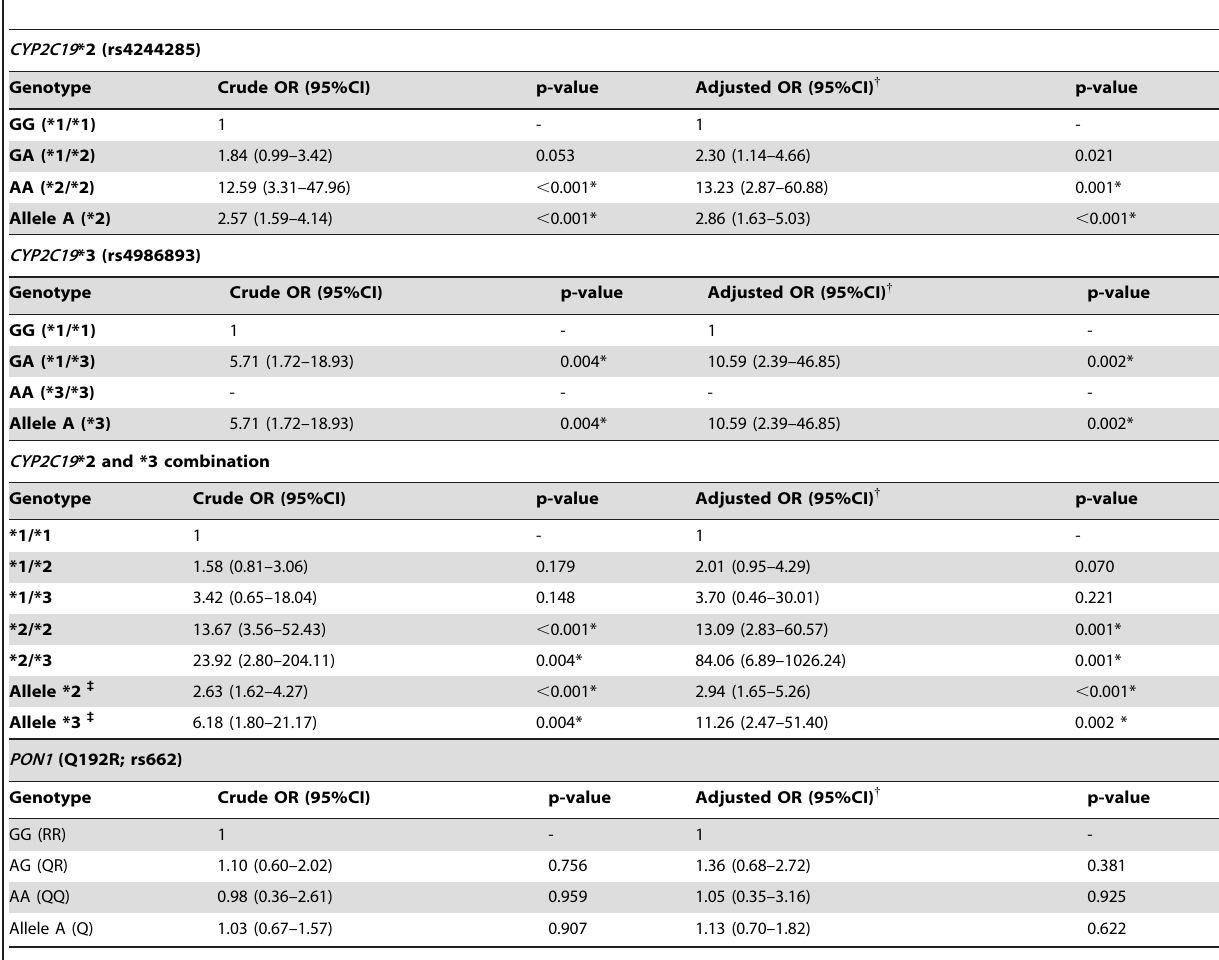
Table 3. Association between CYP2C19*2, *3, PON1 Q192R and clopidogrel resistance.